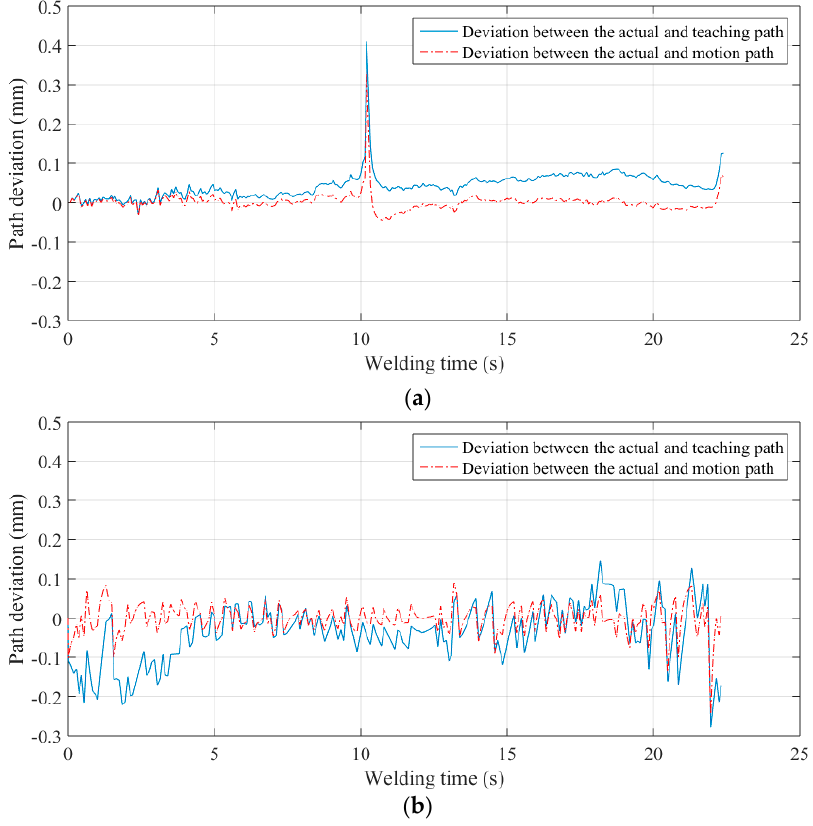
Figure 31. The path deviation during welding. ( a ) The path deviation during welding straight path; ( b ) The path deviation during welding S-curve path.